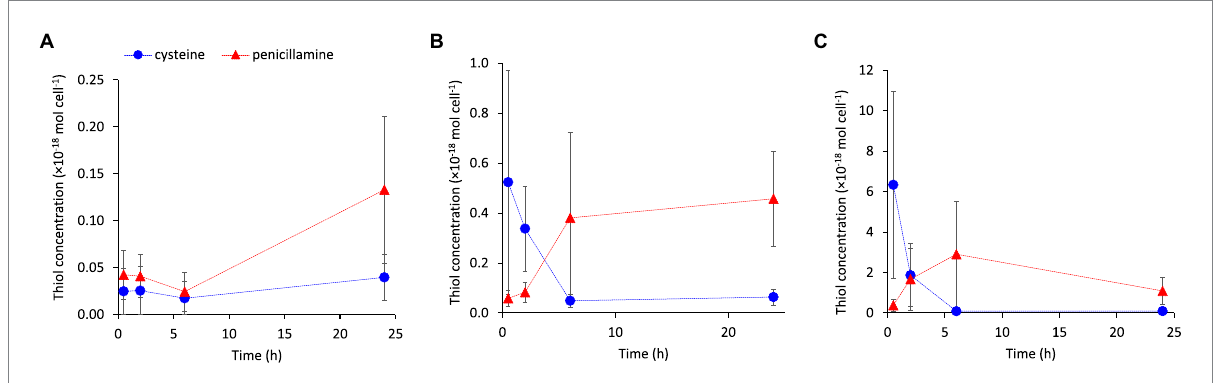
FIGURE 5 Extracellular concentrations of cysteine and penicillamine over time in washed-cell assays with “Standard buffer” containing 30 nM Hg(II) following the addition of (A) 0, (B) 100 nM or (C) 600 nM cysteine. Error bars represent standard error, n =